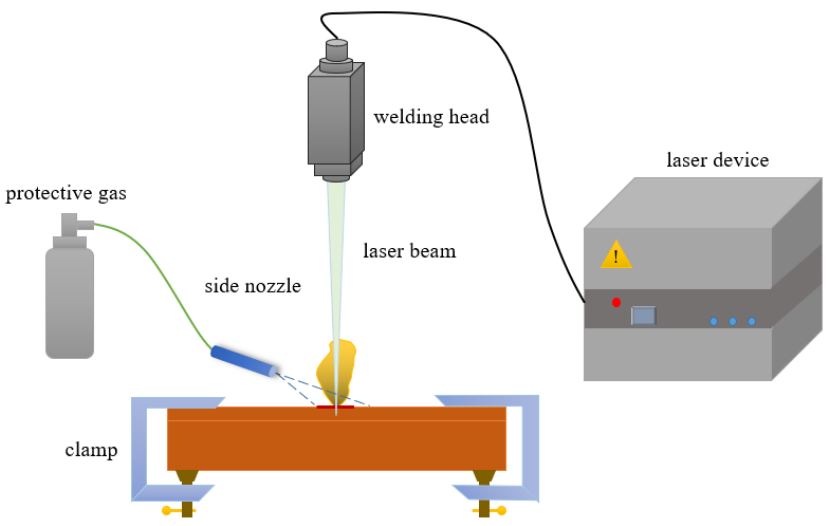
Figure 1. Schematic diagram of laser spot micro-welding (LSMW) experiments.